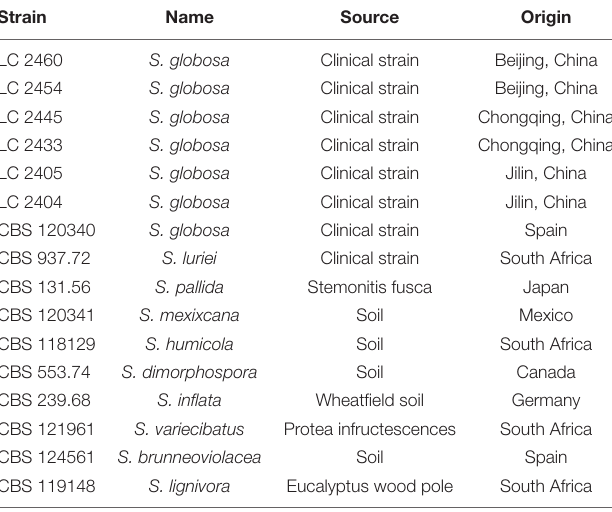
TABLE 1 | Summary of isolates used in this study.